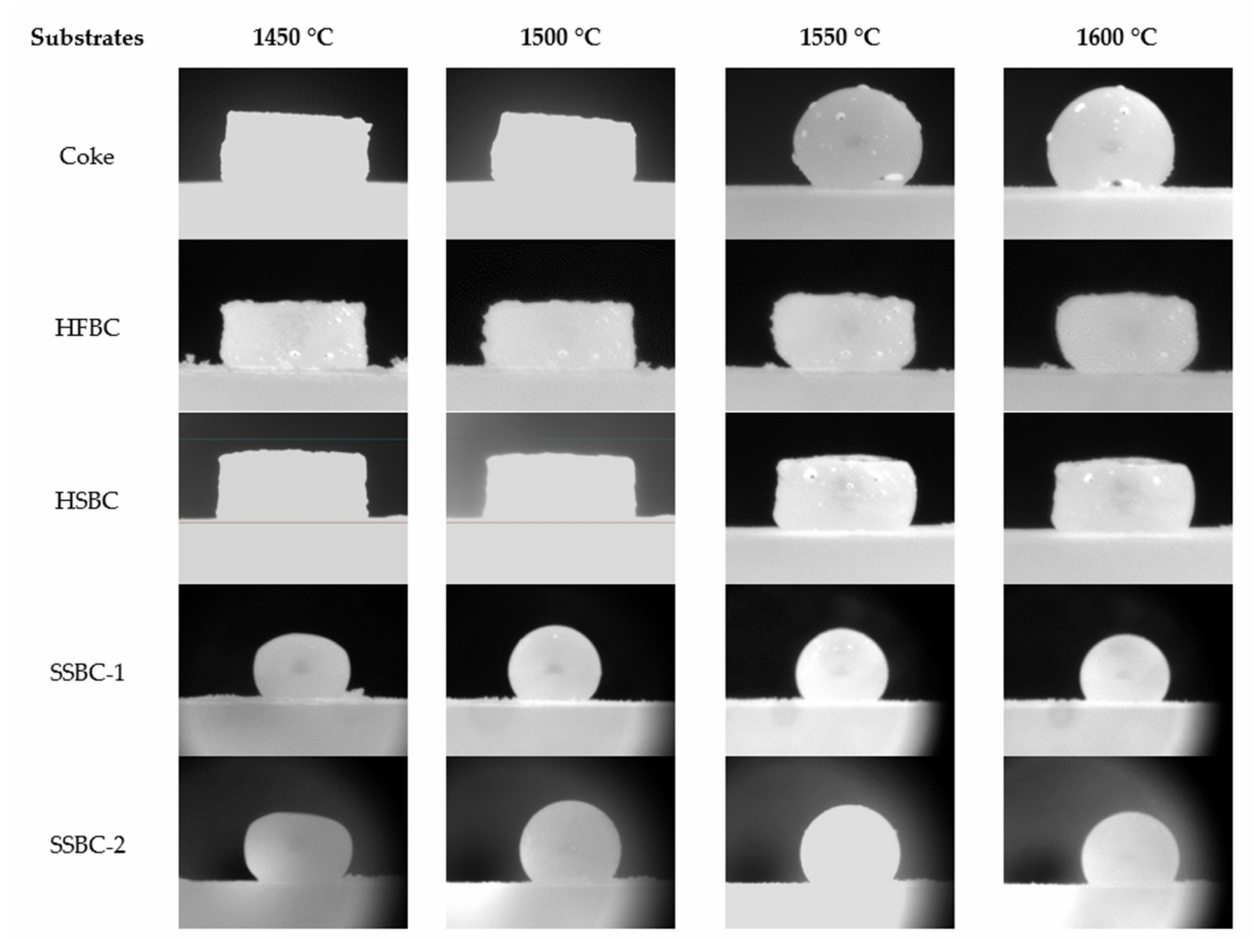
Figure 6. Interaction between slag and coke, and between slag and different bio-char